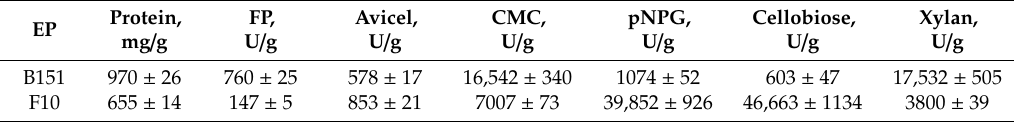
Table 1. Properties of P. verruculosum enzyme preparations (EP).